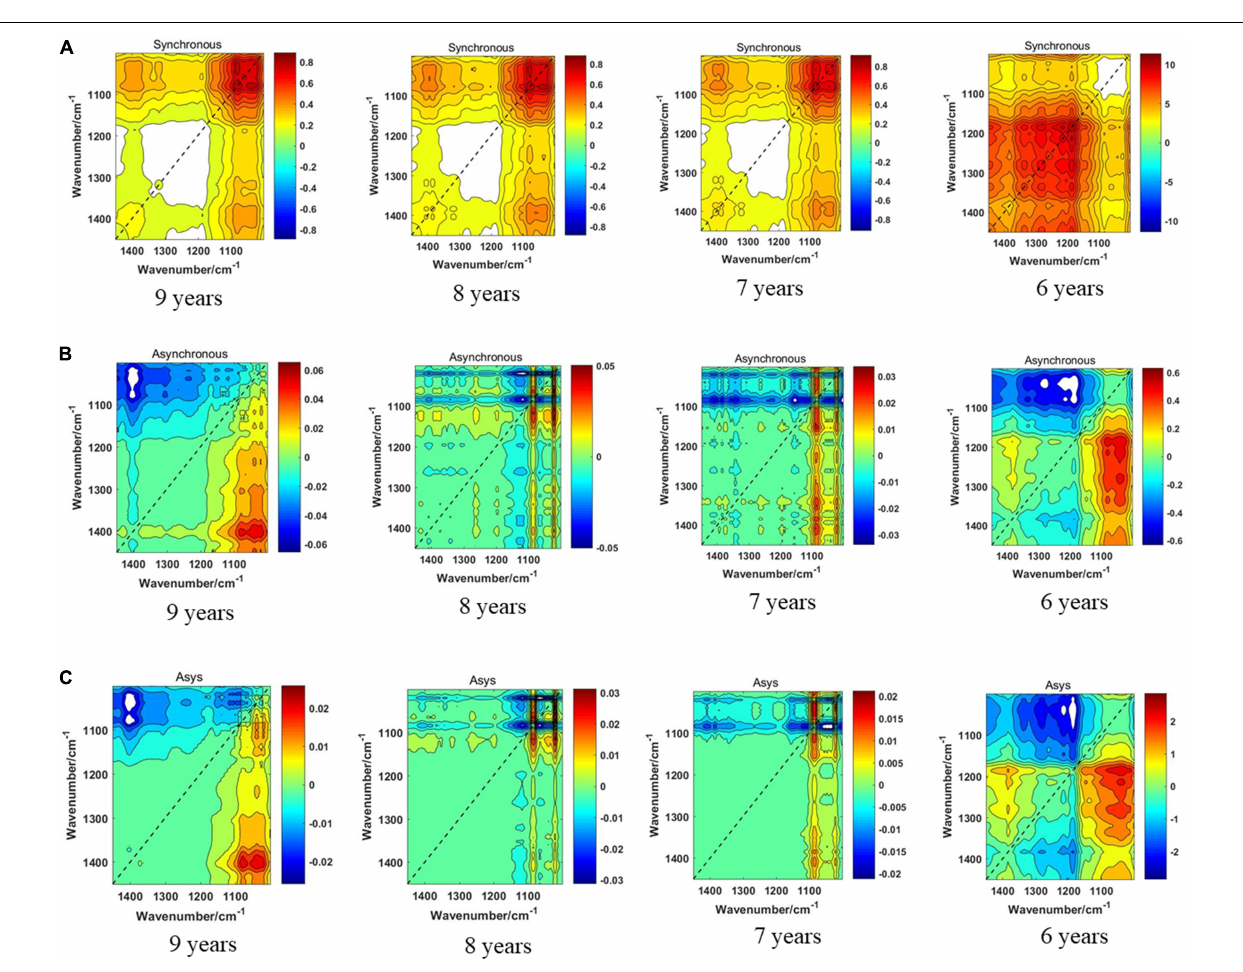
asynchronous 2DCOS of boletes with different storage periods are diverse from each other. We can see clearly that there are two cross-peaks at 1,043 and 1,403 cm − 1 in the spectra of the 9-year storage period, and there are two cross-peaks at 1,043 and 1,200 cm − 1 in the spectra of the 6-year storage period. The